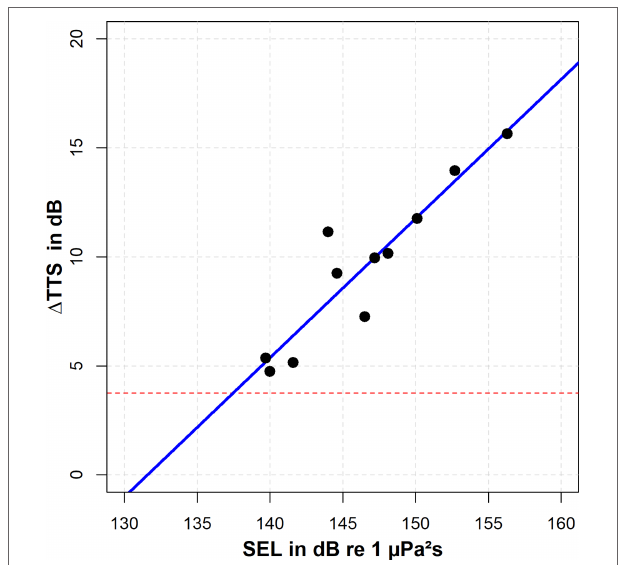
FIGURE 7 | Effects of a 28 kHz tone exposure with a duration of 3.5 s on hearing thresholds at 28 kHz (black circles). The horizontal red dashed line represents the critical value of 3.8 dB shift, which indicates the threshold of significance. A linear regression was calculated in order to estimate the TTS onset , using only exposures which led to a TTS. The SEL-TTS onset at 28 kHz was determined as 137.4 dB re 1 µPa²s.